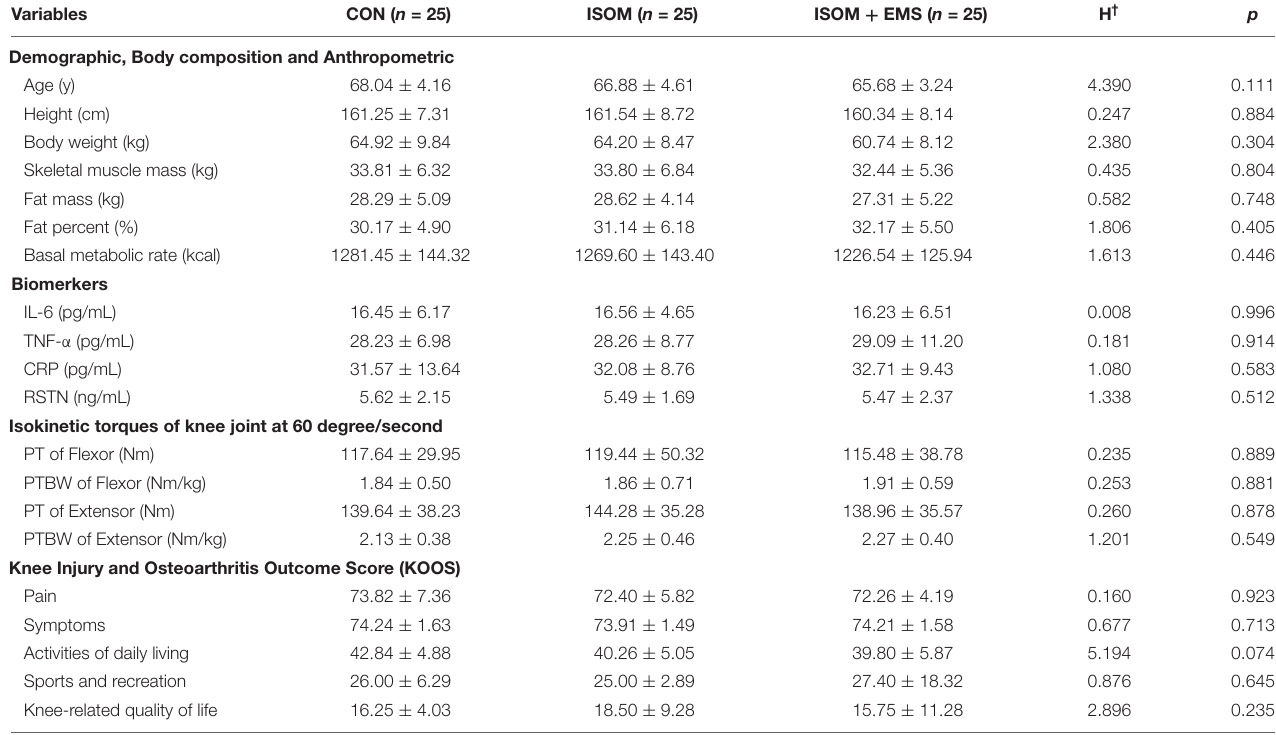
TABLE 1 | Demographic and baseline